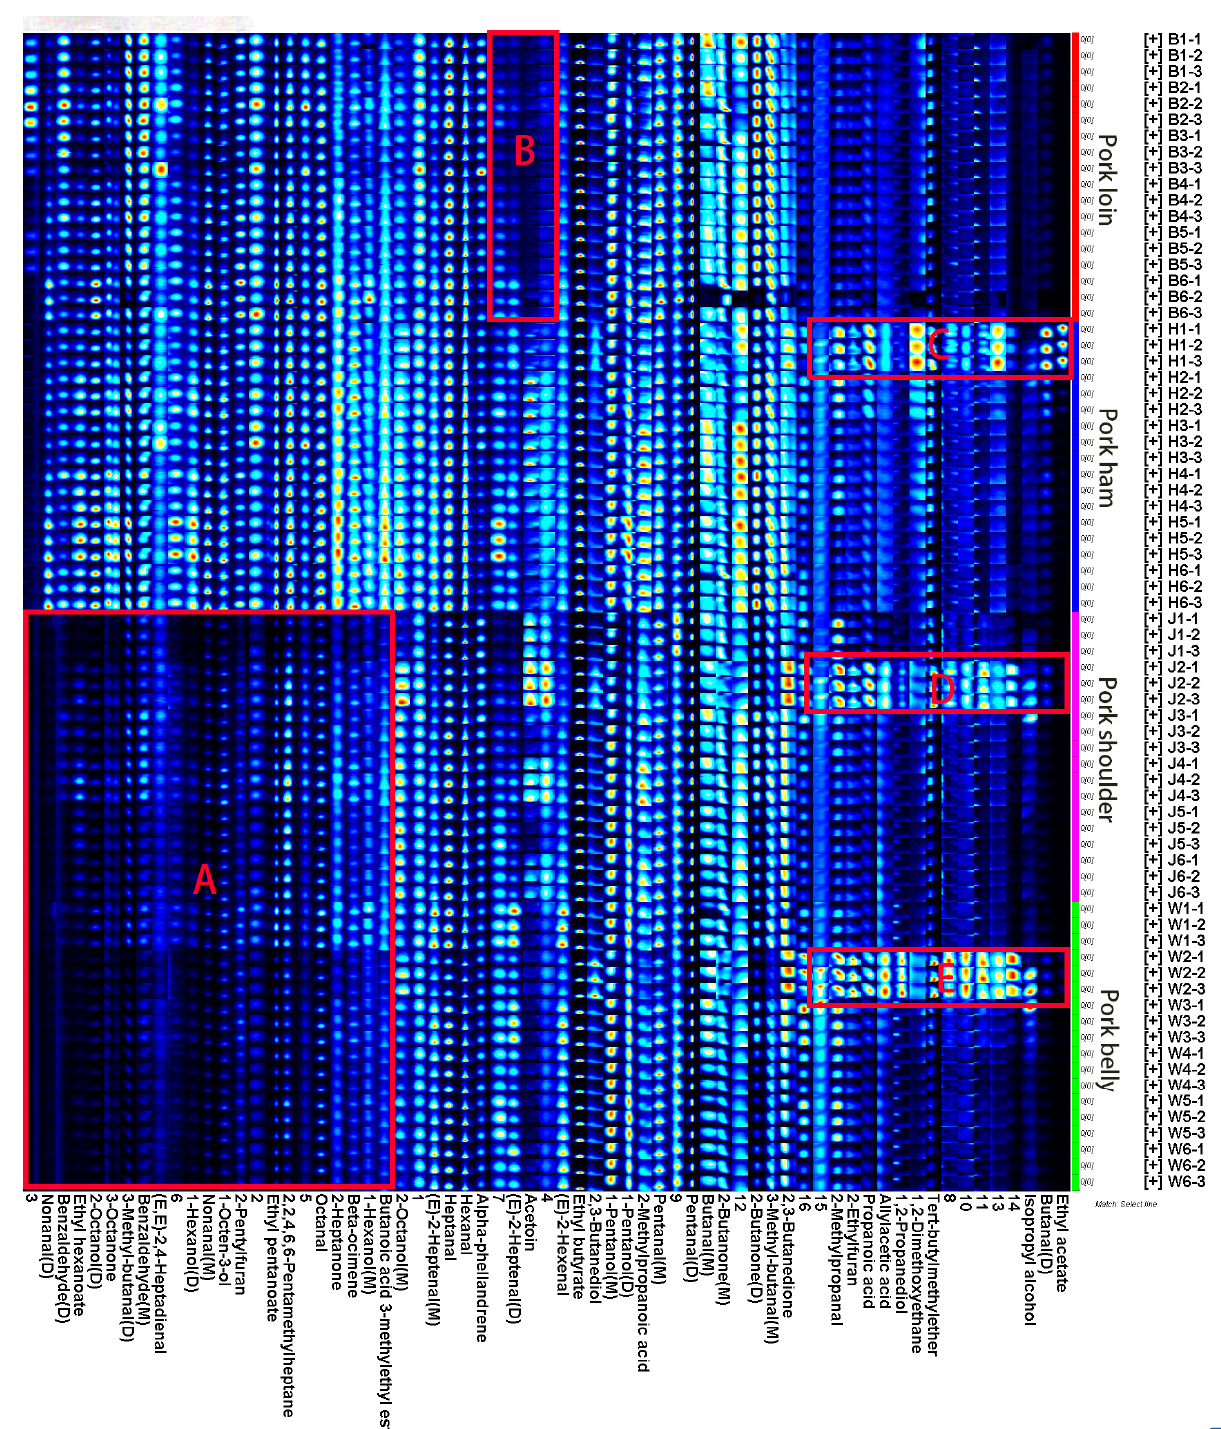
Figure 3. Fingerprints of volatile organic compounds in four muscles of pork (note: B represents for pork loin, H represents pork ham, J represents pork shoulder, and W represents pork belly).